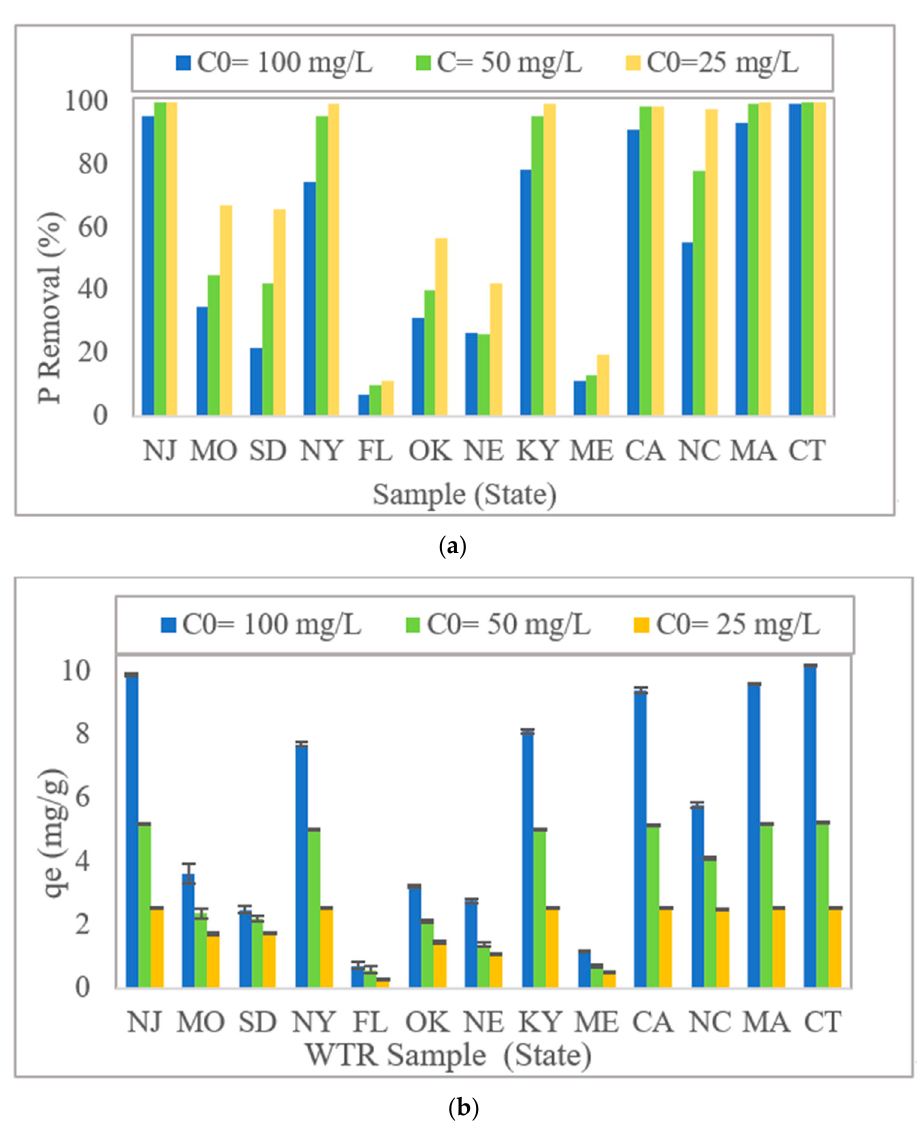
Figure 2. ( a ) Phosphorus removal rate and ( b ) adsorption capacity of Al-WTRs with varying phos- phorus concentrations. Table 2. Maximum adsorption capacity of